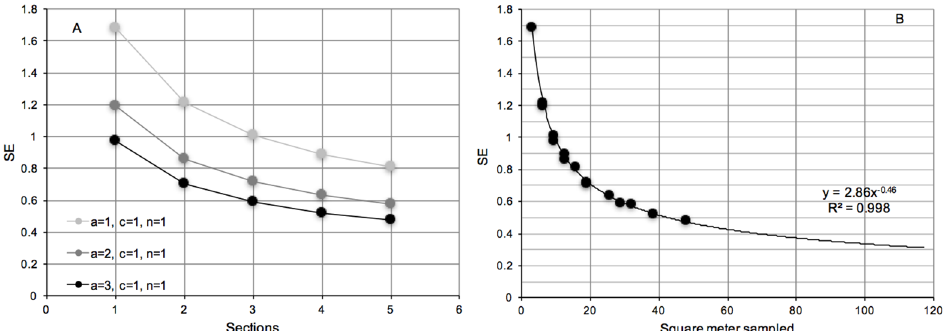
Fig 9. Analysis of sampling precision. (A) Expected standard errors of estimated abundances(m -2 ) using video for different samplingdesigns(a = number of transects, c = number of persons, n = number of repetitionsper person). (B) Expected standarderrors as a function of area